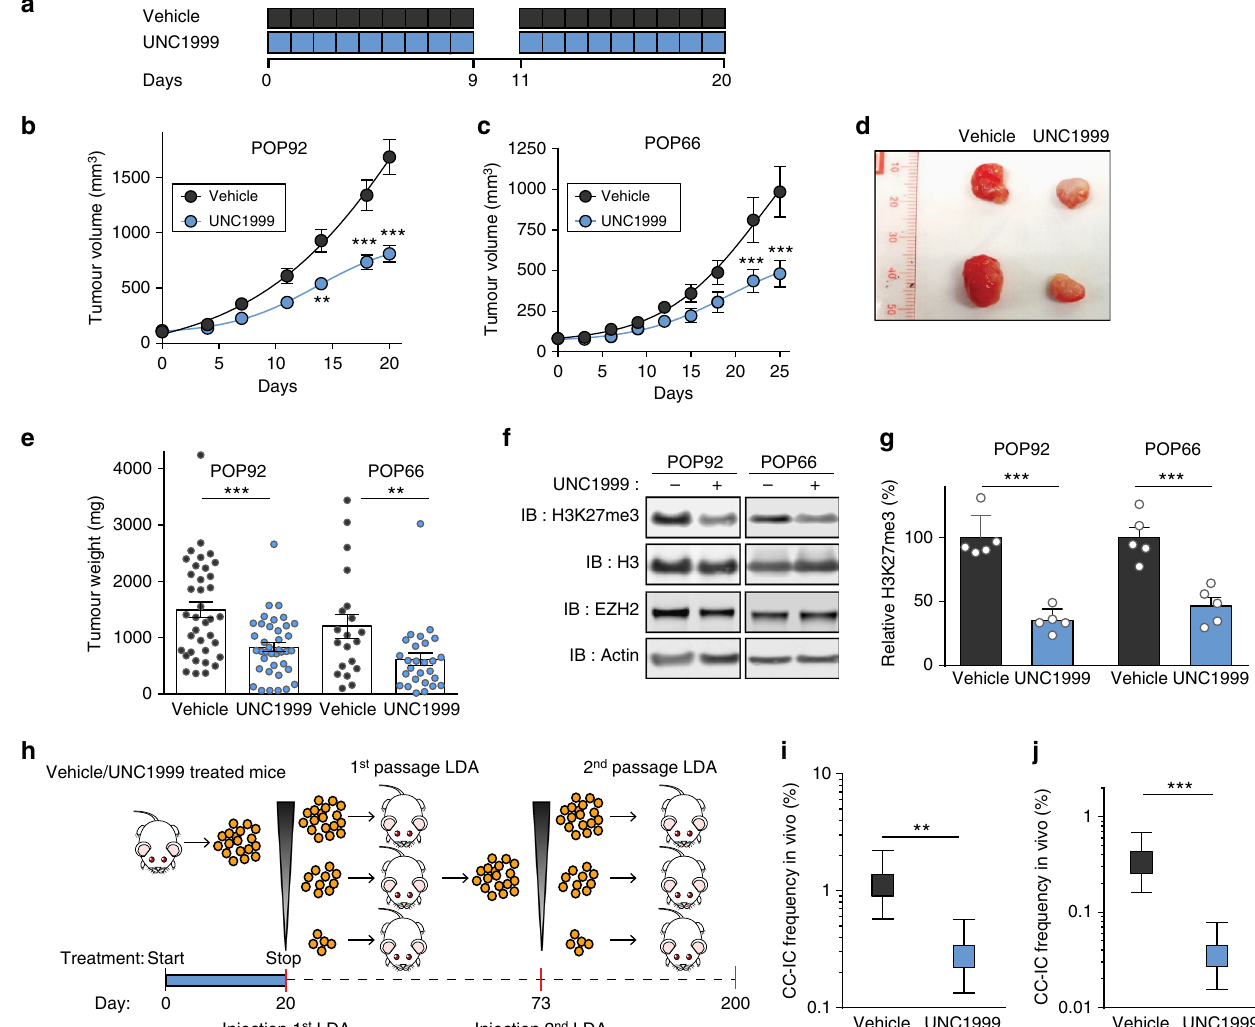
Fig. 3 Inhibition of EZH2 reduces tumour growth and CC-IC frequency in vivo. a Dosing schedule for UNC1999 in vivo. Mice are dosed for 11-day cycles of 9 continuous days followed by a 2-day break. b , c Tumour volume measurements of POP92 and POP66. Mice were treated with vehicle or UNC1999 at 300 mg per kg of body weight for 20 days ( b ) or 25 days ( c ). Data shown are n = 37 tumours ( b , vehicle), n = 42 ( b , UNC1999), n = 20 ( c , vehicle) or n = 30 ( c , UNC1999) ± SEM, with two-way ANOVA. d Images of tumours from POP92 collected in ( b ). e Tumour weight measurement from xenografts collected in ( b , c ). Data are mean of n = 37 tumours (POP92 vehicle), n = 42 (POP92 UNC1999), n = 20 (POP66 vehicle) or n = 30 (POP66 UNC1999), ± SEM, Student's t test. f Representative western blots showing the reduction of H3K27me3 in the xenografts collected from POP92 and POP66 samples in ( b , c ) respectively. g Quanti fi cation of the western blots in ( f ) for H3K27me3 signal over total H3 normalised to the vehicle control. Data shown are n =